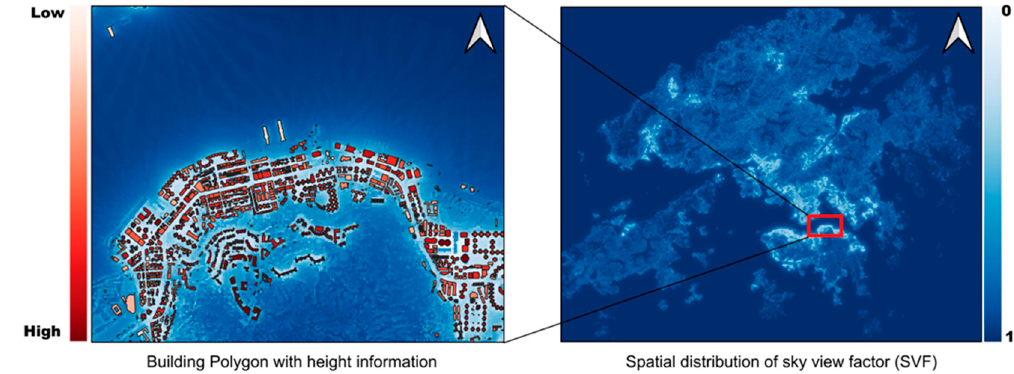
Figure 3. The building polygon and sky-view factor (SVF) datasets.